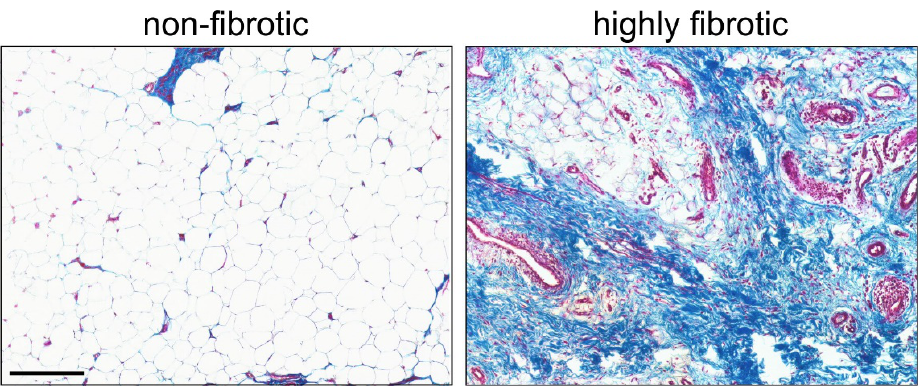
Figure 2. Masson trichrome staining of a non-fibrotic IFP (left) and a highly fibrotic IFP (right) of patients undergoing TKA for primary knee OA. In the left image, there is plenty of adipocytes and low fibrosis, whereas the right image shows fibrotic tissue of IFP with a reduction of adipocytes and a great increase of collagen fibers as well as intense neovascularization. Collagen fibers stained blue, nuclei stained dark purple and cytoplasm/muscle fibers stained red. Bar: 200 μm.